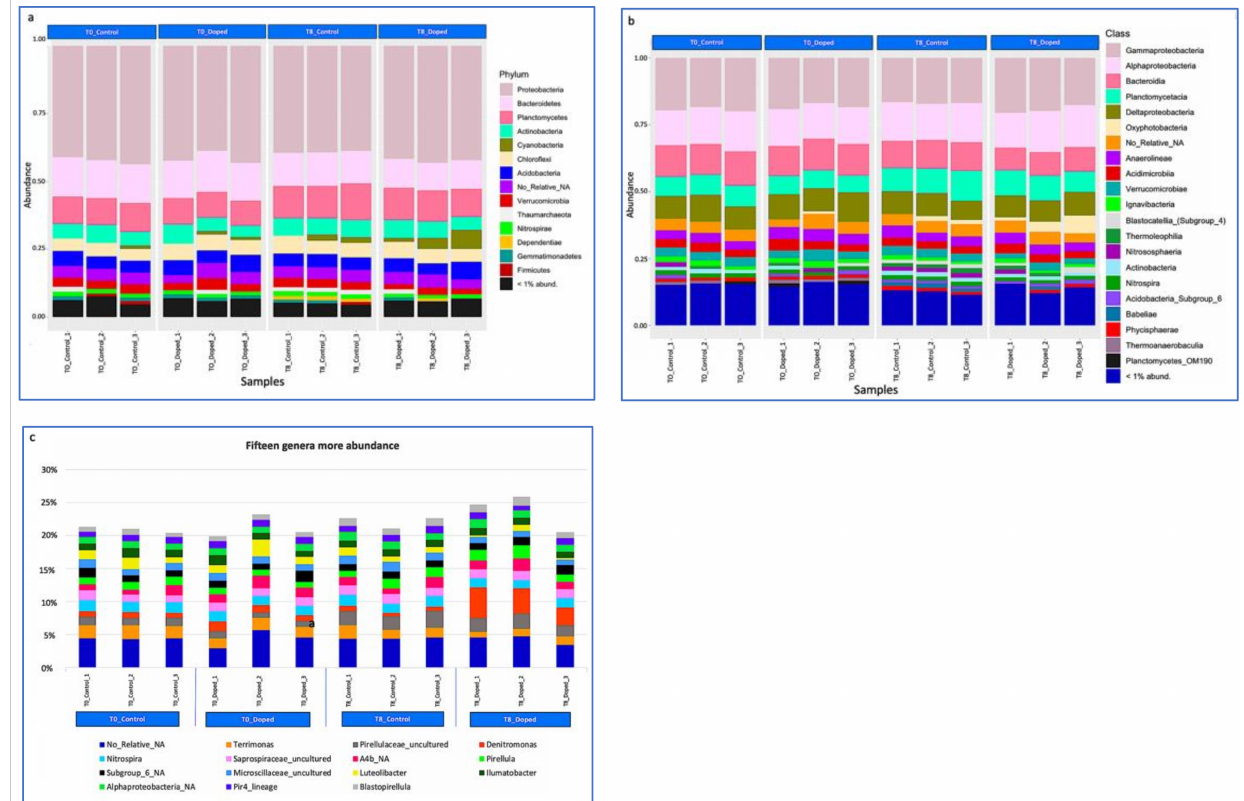
Figure 10. ( a ) Abundance of the major phyla, ( b ) classes with abundance > 1% and ( c ) genera more abundant of bacteria across the different CWs systems substrates, irrigated for eight weeks with Ribeira de Joane water not doped (control) or doped with PCP. Samples collected at the beginning (T0) and at the end of the experiment (T8) ( n = 3). <1% abund. groups the phyla with abundance lower than 1%; and “No_Relative_NA” groups the phyla without any close